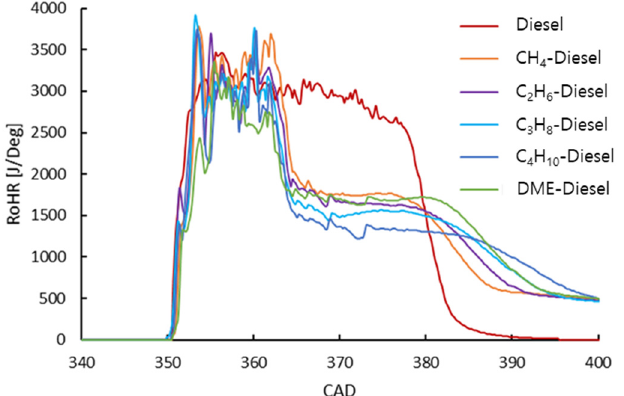
Figure 9. Rate of heat release diagrams